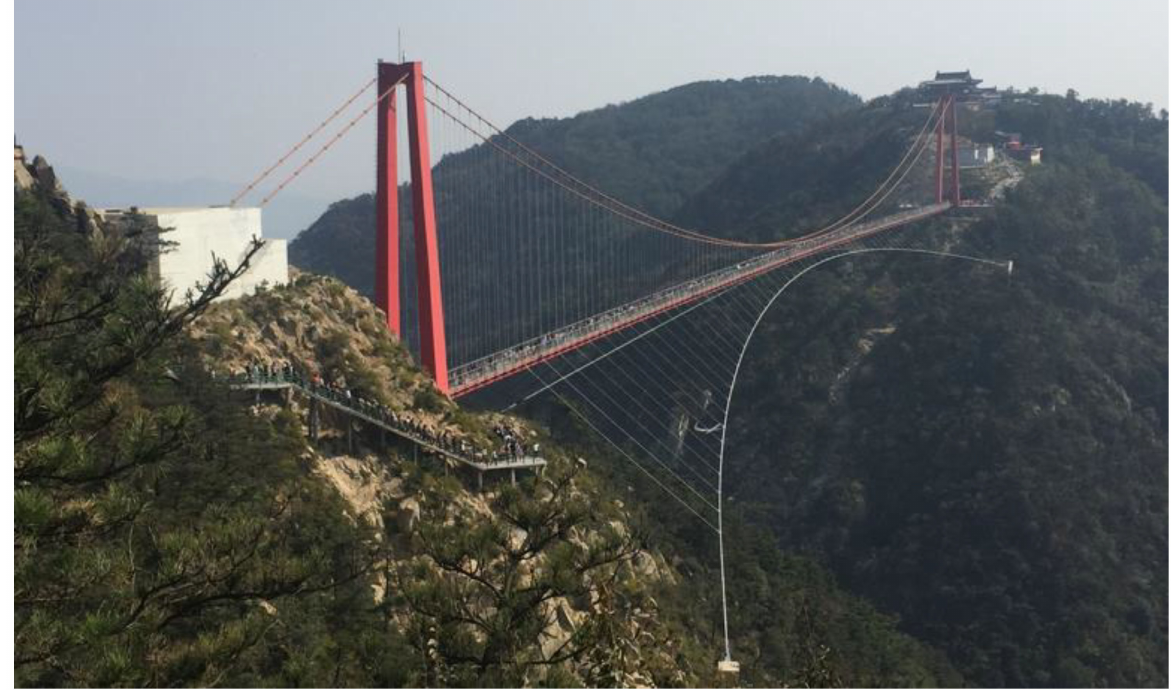
Figure 1. Tianmeng Bridge in Shandong province,